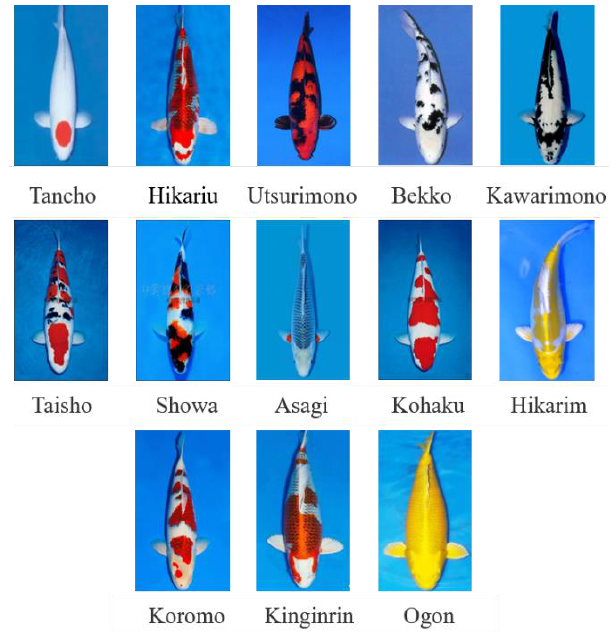
Figure 1. Images of thirteen kinds of koi.